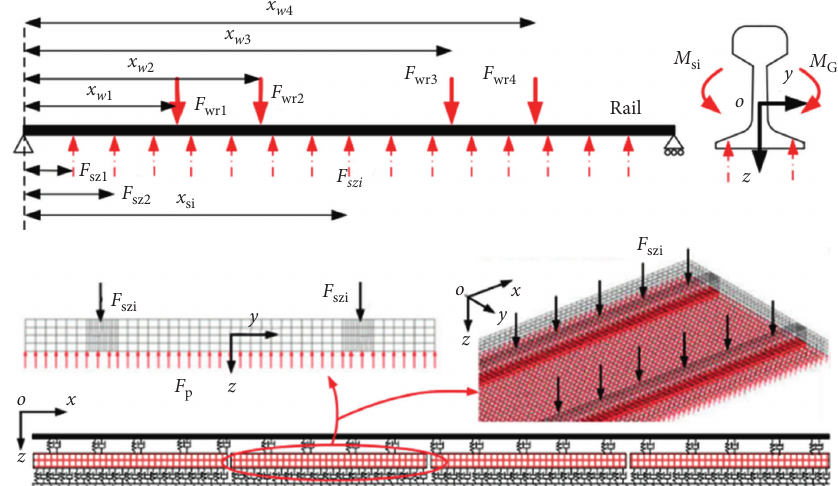
Figure 1: Schematic diagram of the force applied on the